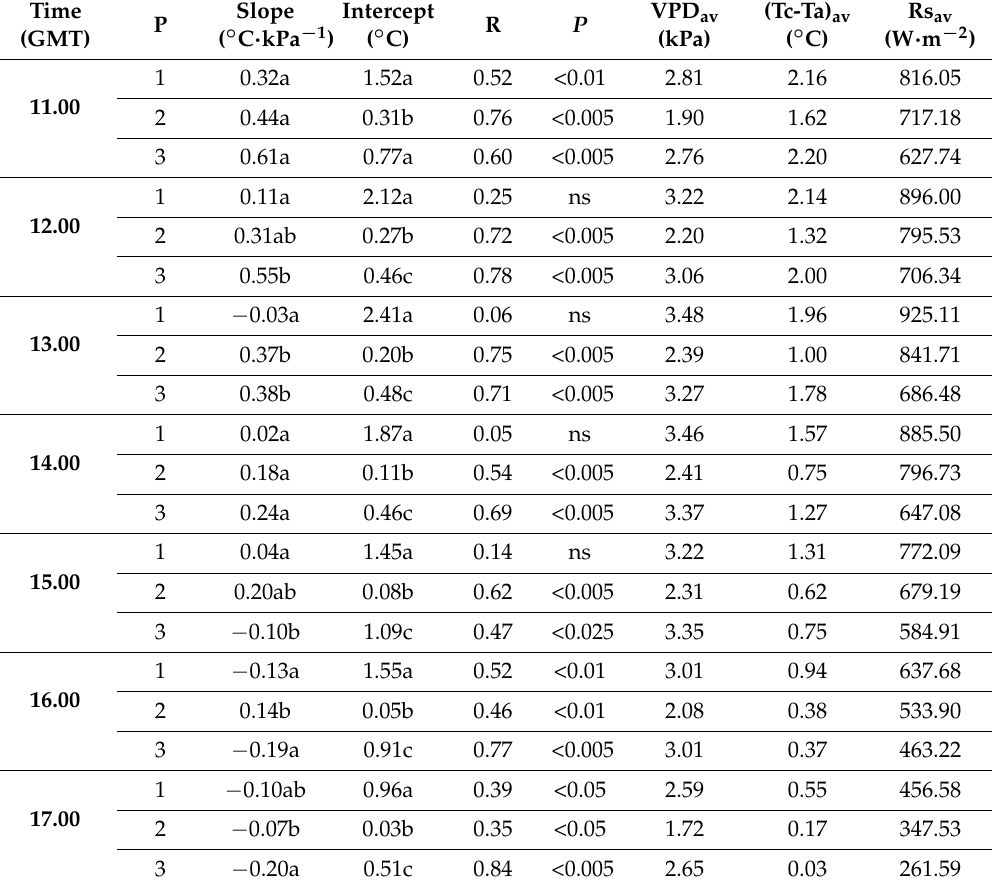
Table 3. In the afternoon, some slopes became negative, mainly during P3. In addition, the slopes values were lower than in Table 2 except between 10.00–12.00 GMT for P3 when the slope was the steepest. As for the NWSB-intercepts, for P1 and P3, the values were higher than when all the days were plotted together (Table 3). The intercepts from P2 did not increase, as the Tc-Ta levels were lower than the others periods of study. An example of how the lower Tc-Ta the lower VPD and NWSB-intercept, as in P2, is depicted in Figure